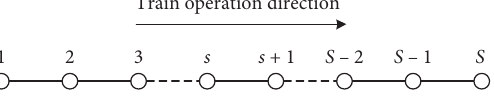
Figure 2: The representation of one direction on a